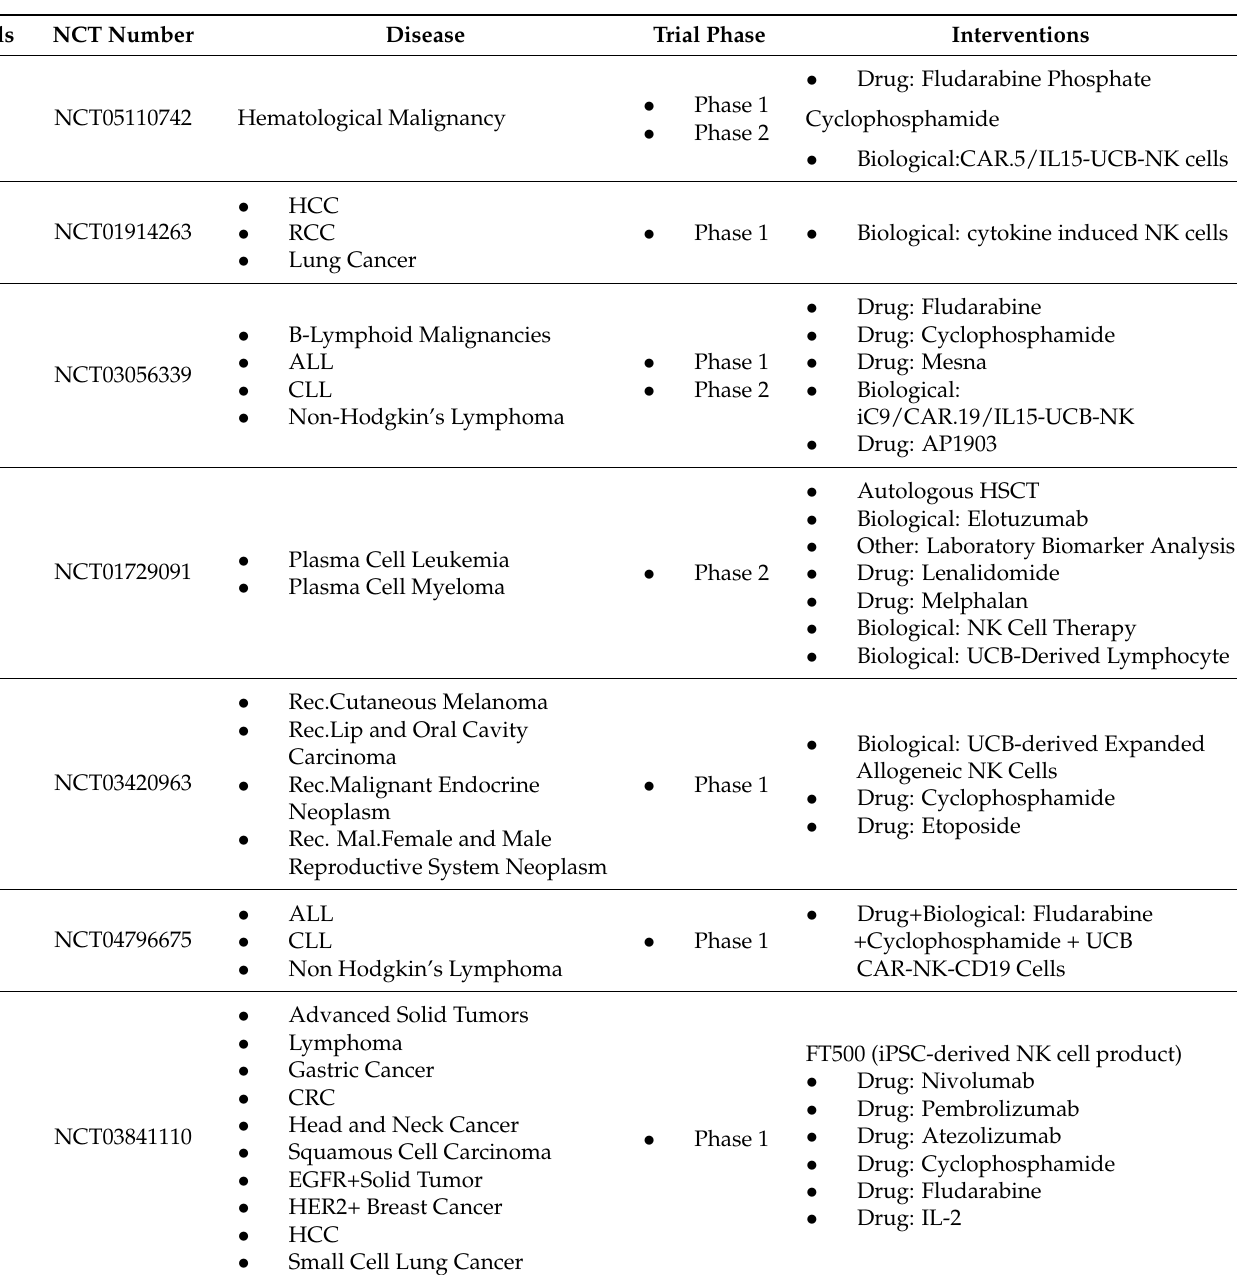
Table 2. Ongoing clinical trials with UCB-NK cell-based therapies in hematological and solid tumors. HCC (Hepatocellular Carcinoma); RCC (Renal Cell Carcinoma);ALL (Acute Lymphoid Leukemia); AML (acute myeloid leukemia); Rec.(Recurrent); Rec. Mal. (Recurrent Malignant); CML (Chronic Myeloid Leukemia); CLL (Chronic Lymphoid Leukemia); CRC (Colorectal Cancer); MDS (Myeloid dysplastic syndrome); Acc.(Accelerated); HSCT (Hematopoietic stem cell